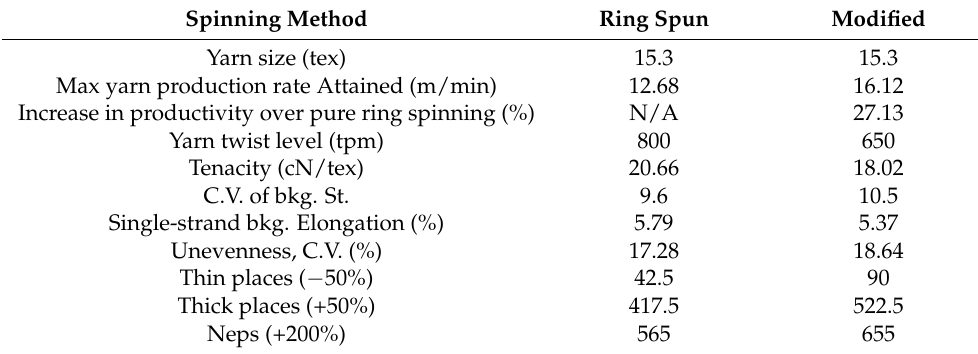
Table 2. Parameters and properties of yarns produced on the pure ring and modified Spintester. Spinning